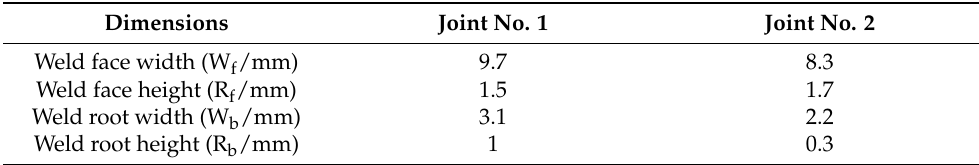
Figure 8. Macrostructure as well as the face and the root of the hybrid-welded joints (having thicknesses of 5 mm and 7 mm): ( a ) joint no. 1 (PA) and ( b ) joint no. 2 (PC). The etched metallographic specimens revealed the clearly visible borders between the base material, HAZ, and the weld. Geometrical dimensions of hybrid-welded joints no. 1 and 2 made in the flat position (PA) and in the horizontal position (PC) are presented in Table 3. Table 3. Geometrical dimensions of hybrid-welded joints no. 1 and 2.